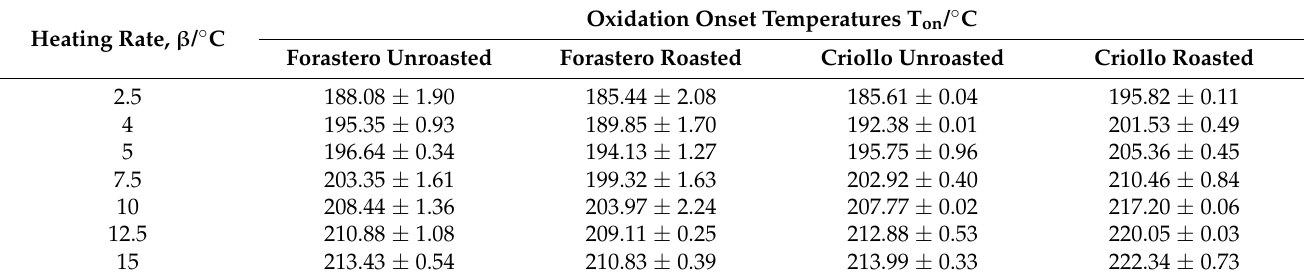
Table 3. DSC heating rates ( β ) and oxidation onset temperatures (T on ) for cocoa butter extracted from cocoa beans. Heating Rate, β / ◦